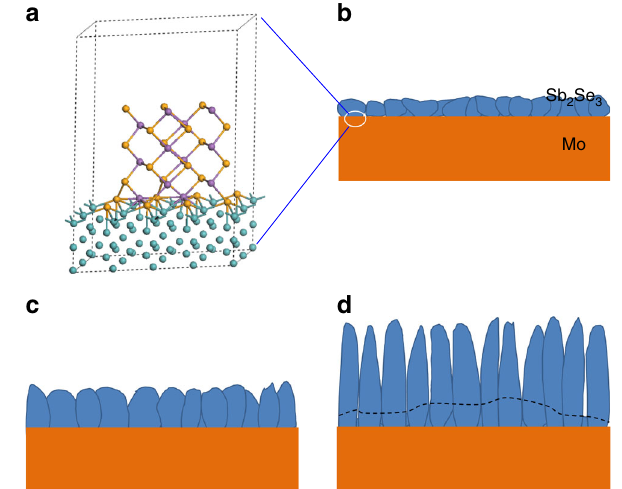
Fig. 3 Growth model of the Sb 2 Se 3 nanorod arrays on Mo substrate. a Atomistic model of Sb 4 Se 6 unit on the (110) plane of Mo. b – d Schematics of the Sb 2 Se 3 at different growth stages, b thin fi lm growth, c split, and morphology and bottom is compact